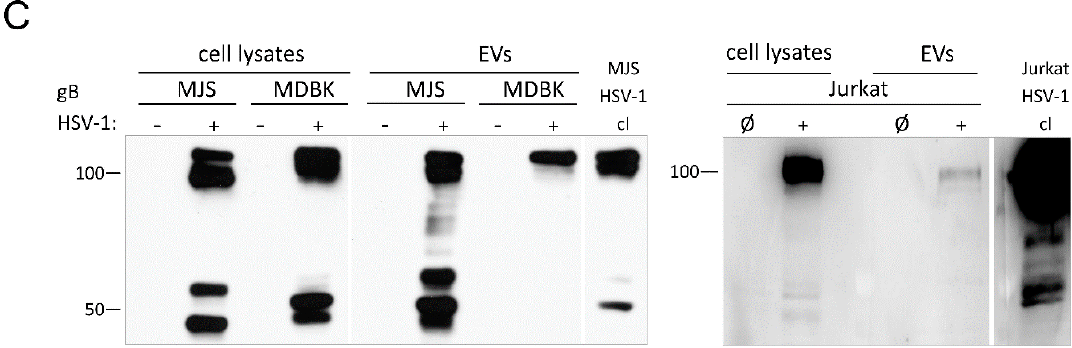
Figure 2. Immunoblotting detection of BoHV-1 ( A ), PRV ( B ), and HSV-1 gB ( C ) in cell lysates (cl) of constructed cell lines or SEC-isolated EVs. ( + ): gB-expressing cells; ( − ): MJSpuro, MDBKpuro, SK6puro, or untransduced Jurkat cells (Ø) were used as negative controls. Virus-infected cell lysates (cl) were analyzed as positive controls; in the case of BoHV-1, gB was immunoprecipitated (IP) with H2 antibody before immunoblotting with anti-BoHV-1 serum. Size markers are in kilodaltons. gBa: uncleaved BoHV-1 and PRV gB precursor; gBb: cleaved N-terminal gB subunit; gBc: cleaved C-terminal gB subunit.